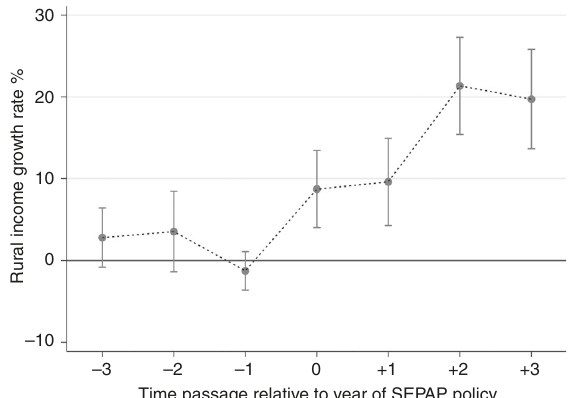
Fig. 1 Parallel trend using full samples. Illustration of annual difference in the growth rate of rural income per capita before and after treatment (PV poverty alleviation policy) to demonstrate pre-treatment parallel trend assumption and post-treatment estimated effect. The dots indicate point estimates and the vertical lines indicate 95% con fi dence intervals. Source data are provided in the Source Data fi